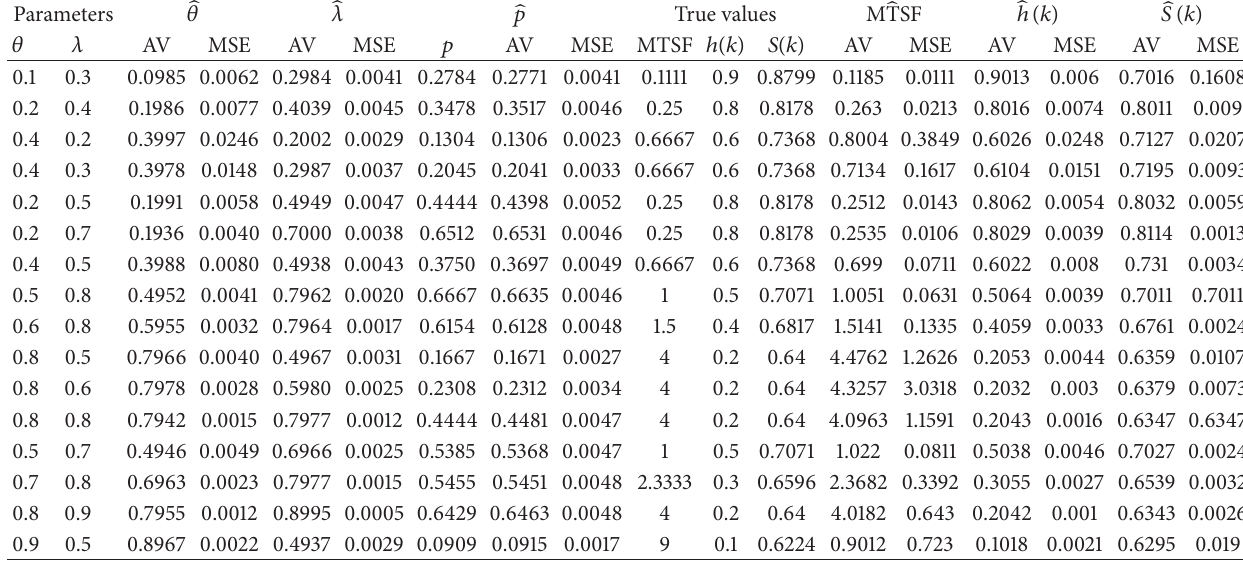
Table 4: MLE of parameters and reliability characteristics when 𝑘 = MTSF/2.